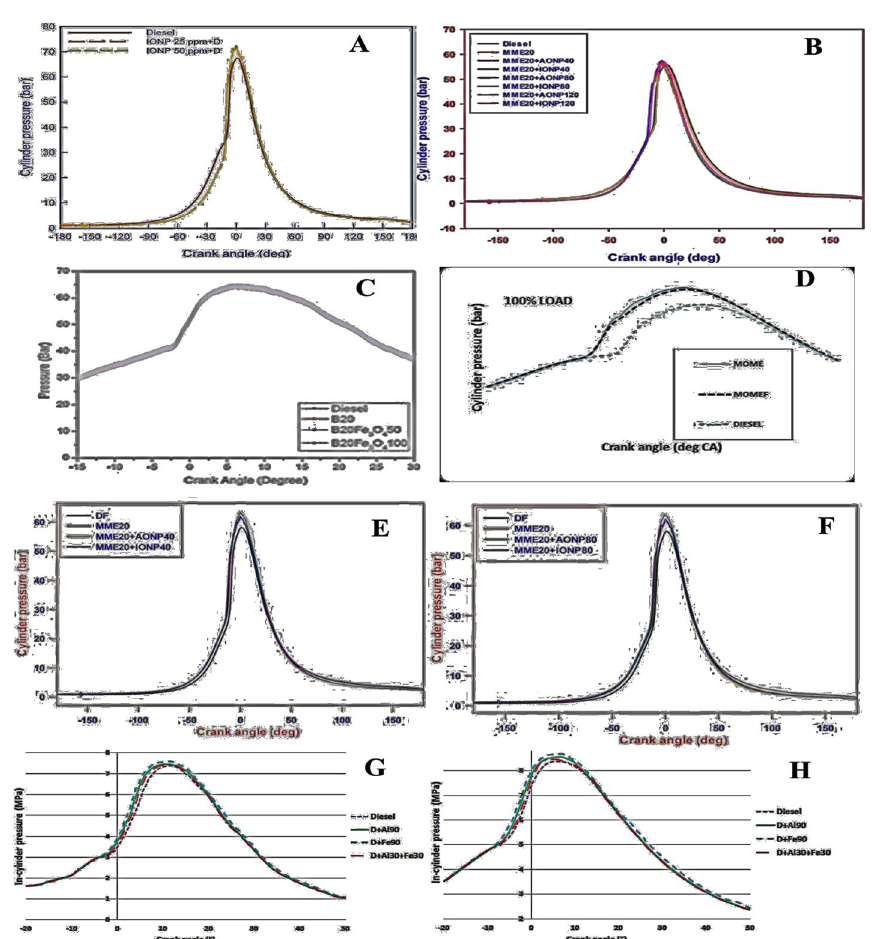
Fig. 9 Effect of cylinder pressure on nano-added diesel or